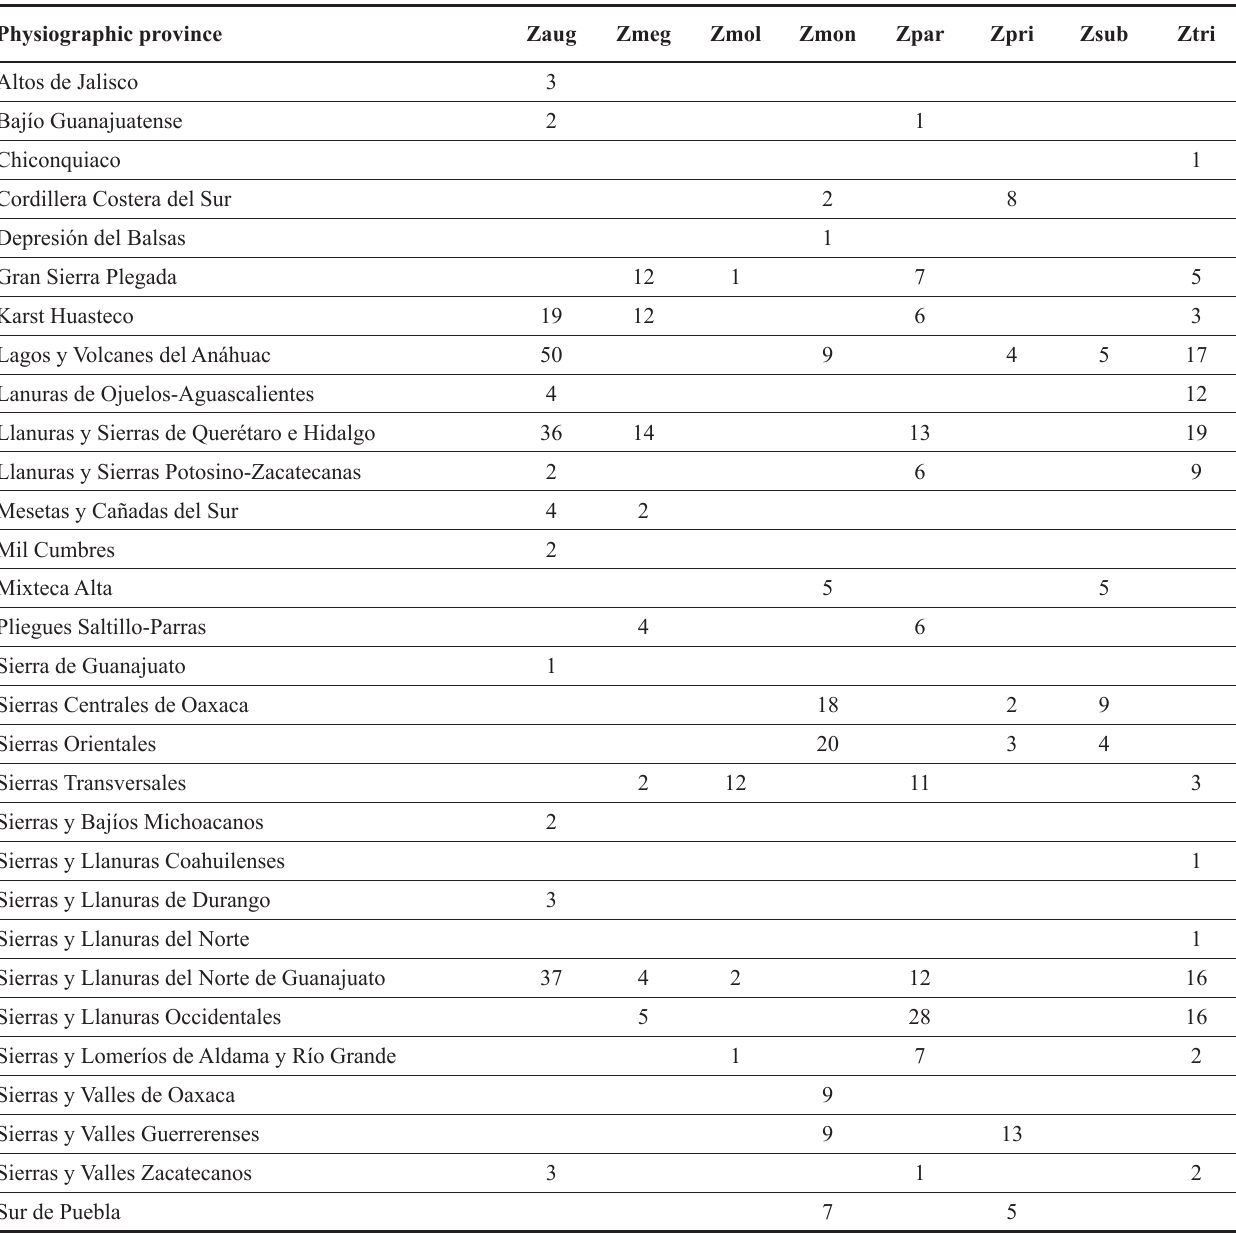
Table 1 – Mexican physiographic provinces where the genus Zaluzania occurs and the number of records for each species. Zaug = Z. augusta , Zmeg = Z. megacephala , Zmol = Z. mollissima , Zmon = Z. montagnifolia , Zpar = Z. parthenioides , Zpri = Z. pringlei , Zsub = Z. subcordata , Ztri = Z. triloba